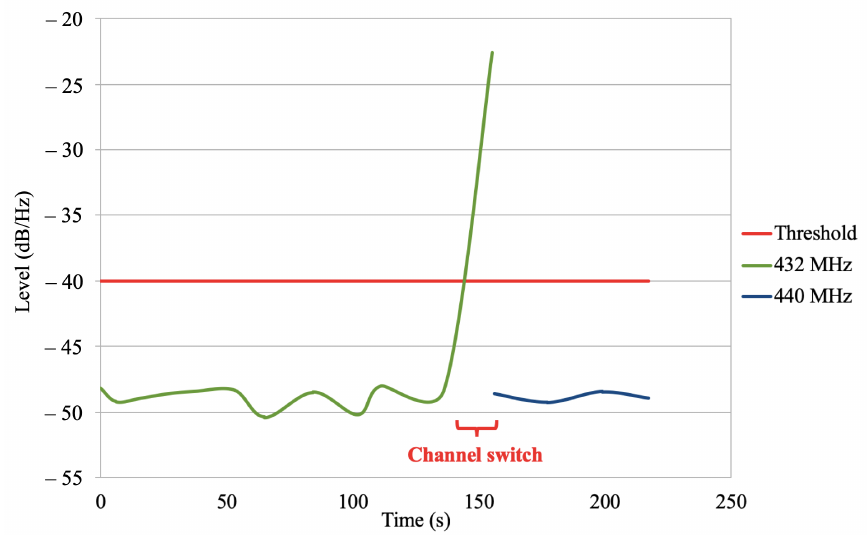
Figure 9. Data collected using the CR-based UAV. It kept using the 432 MHz frequency until it sensed a transmission level over the threshold. It then switched to its backup channel at 440